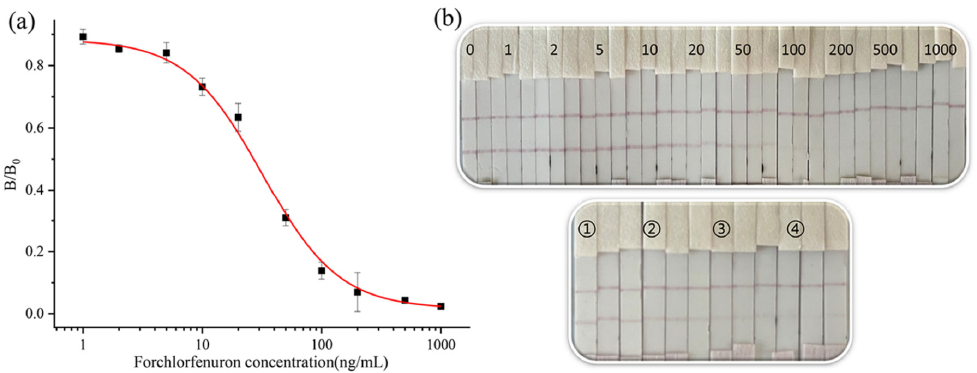
Figure 5. Ic-ELISA curve of CPPU in cucumber samples.